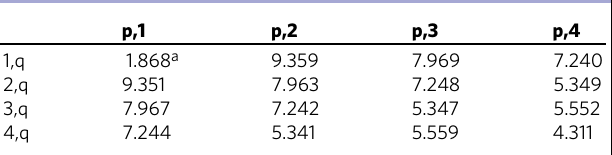
Table 5 DCC parameters-DCC-GARCH (1,